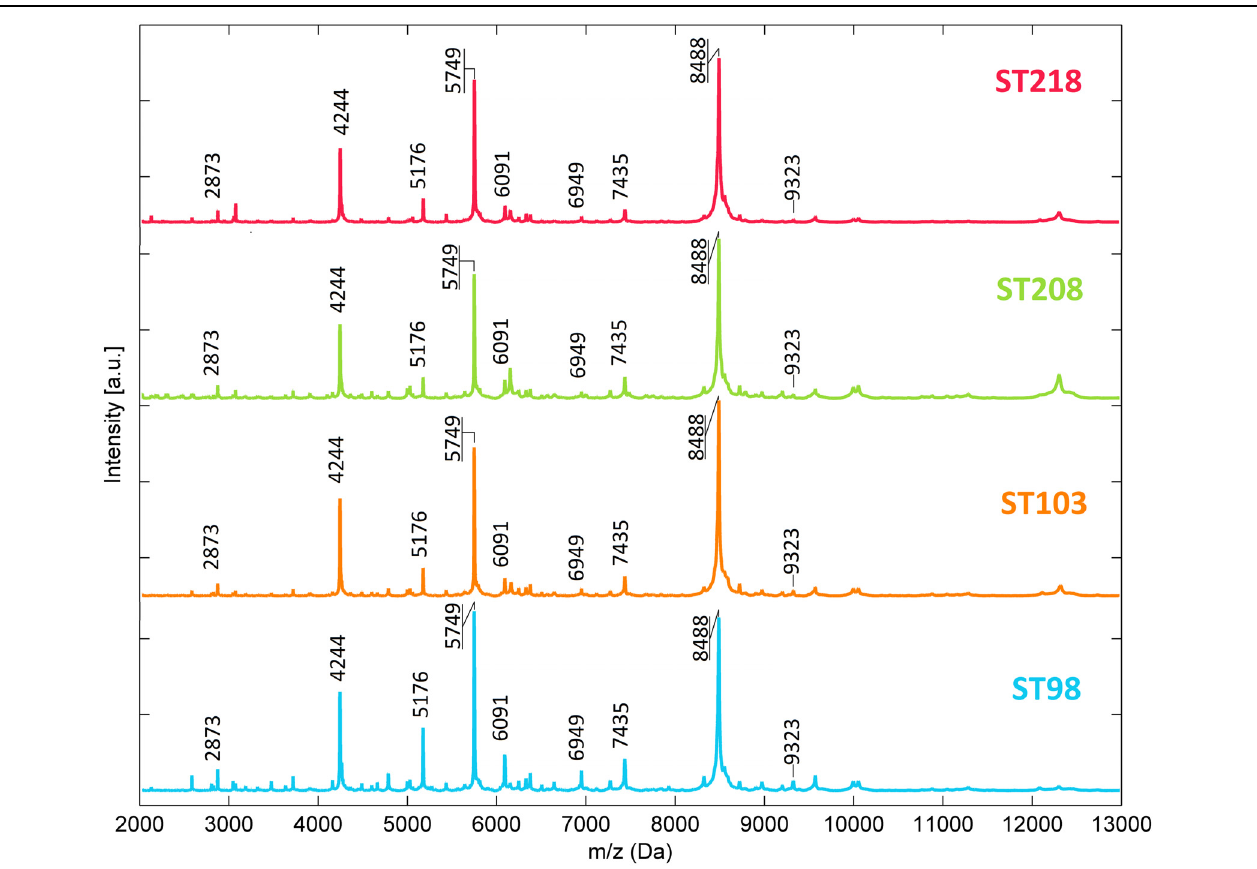
FIGURE 1 | Mass profiles of ST98, ST103, ST208, and ST218 isolates in the region of 2–13 kDa [obtained from the mean spectra of each sequence types